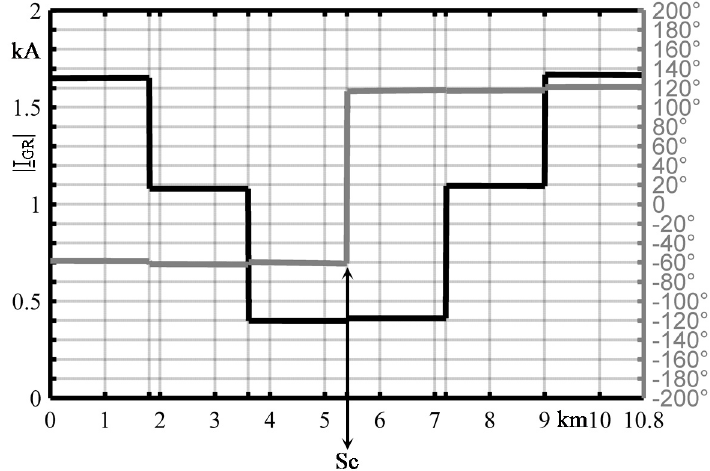
Figure 4. Faulted UGC: ground return current magnitude and angle along the line (CB with PTs); FAULT at